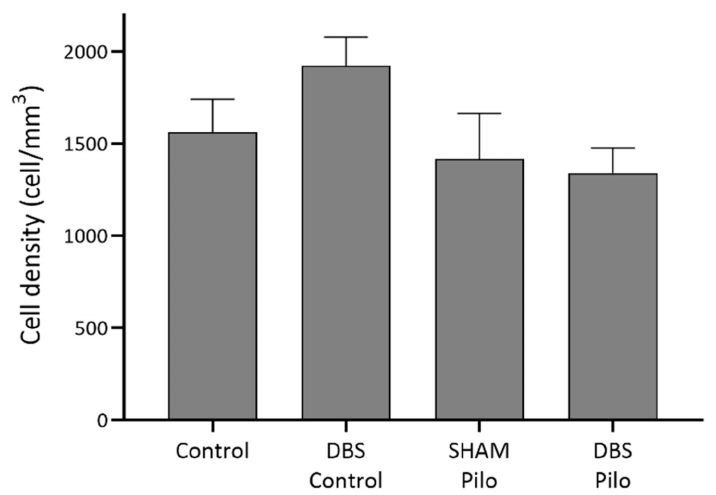
Figure 3. PV+ cell density in stratum oriens, pyramidale, and radiatum of the CA1 subregion of the hippocampus. Deep brain stimulation (DBS) was applied to the basolateral amygdala for 10 days in control (DBS-control) and pilocarpine-induced animals (DBS-Pilo) and compared to controls (control, n = 8) and pilocarpine-induced animals (SHAM-Pilo). No significant differences were observed among the groups. Data are presented as means ± SEM.